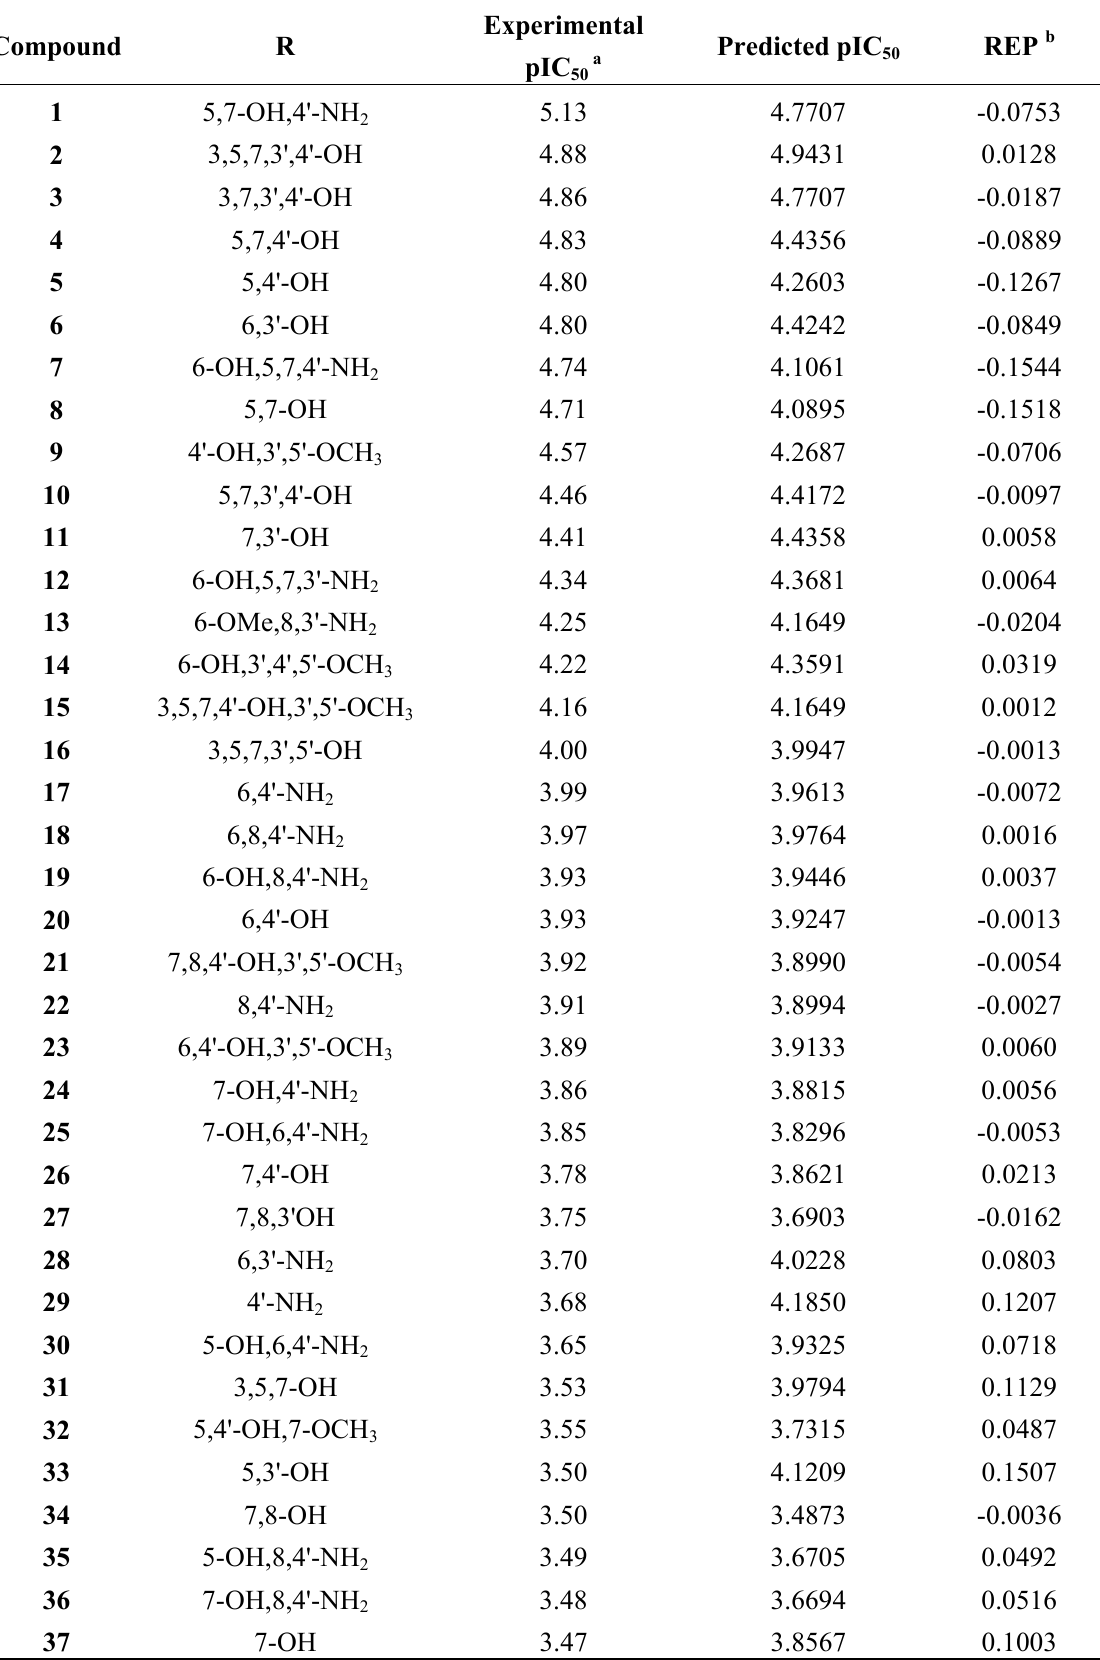
Table 1. Chemical structure of flavonoid